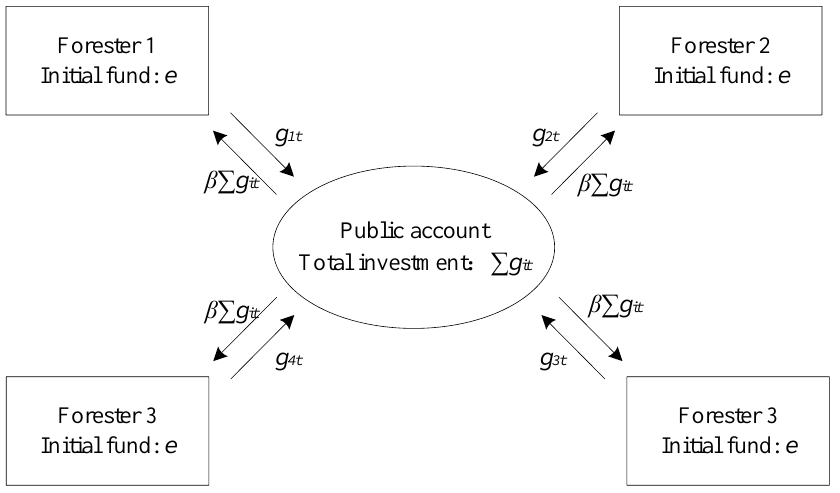
Figure 1. The calculation rules of income.